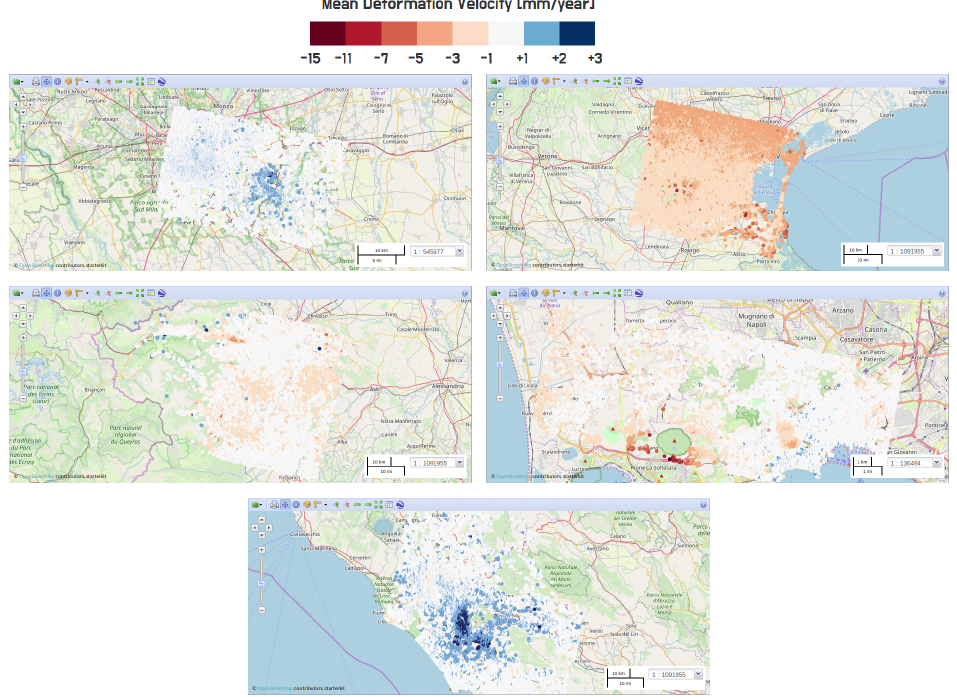
Figure 6. Visualization of mean deformation velocity maps of Milan, Padua, Turin, Naples and Rome, in order from top-left to bottom, on